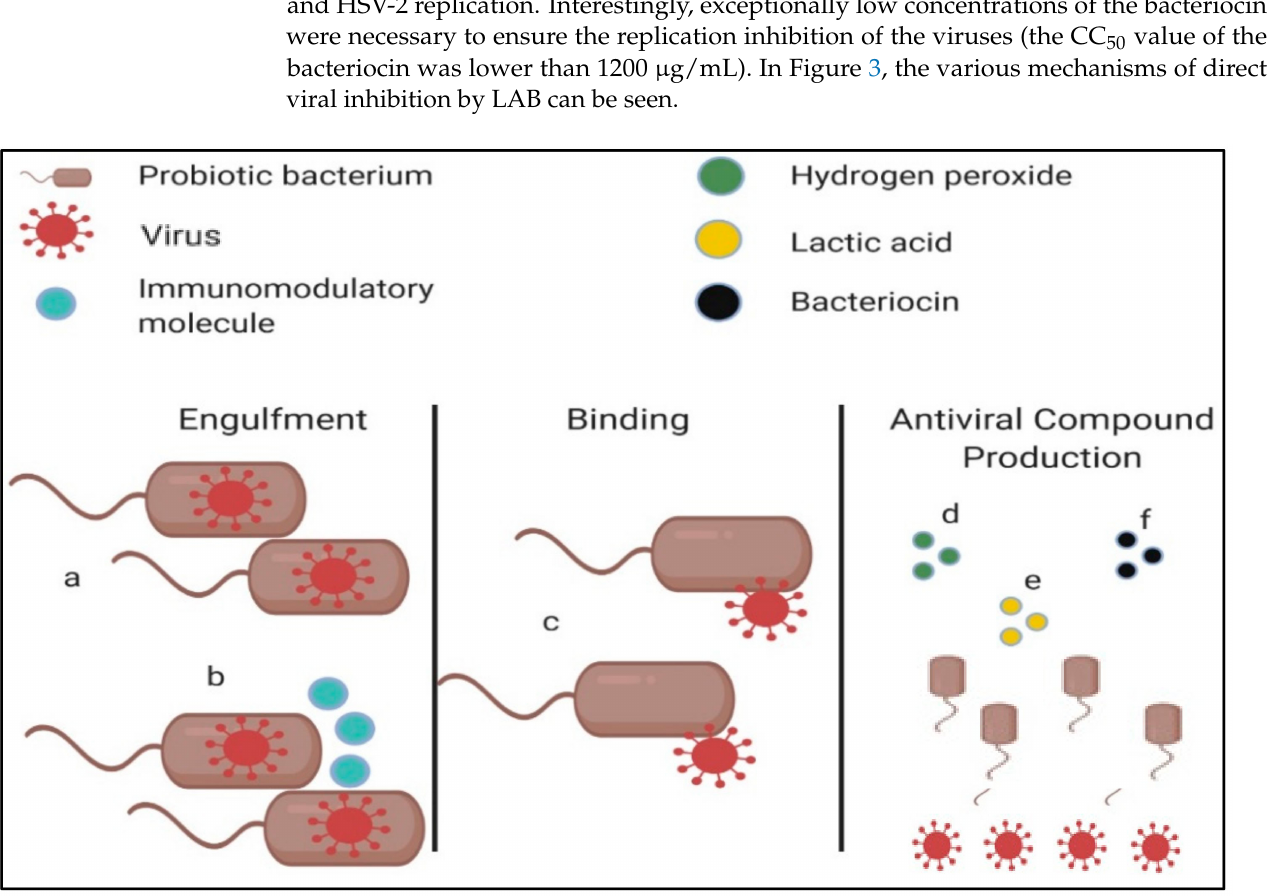
Figure 3. Various means by which probiotic bacteria have been adjudged to directly inactivate viruses. The first mechanism of viral inactivation by probiotics requires the engulfment of viral particles by probiotics ( a , b ). Some strains can engulf virions whilst also producing molecules that can initiate the activation of the innate immune system ( b ). As opposed to viral engulfment, some LAB can inactive viruses by merely binding to them ( c ). Antiviral compounds produced by probiotics have also been studied. These compounds include hydrogen peroxide ( d ), lactic acid ( e ), and bacteriocins ( f ), which initiate the formation of viral